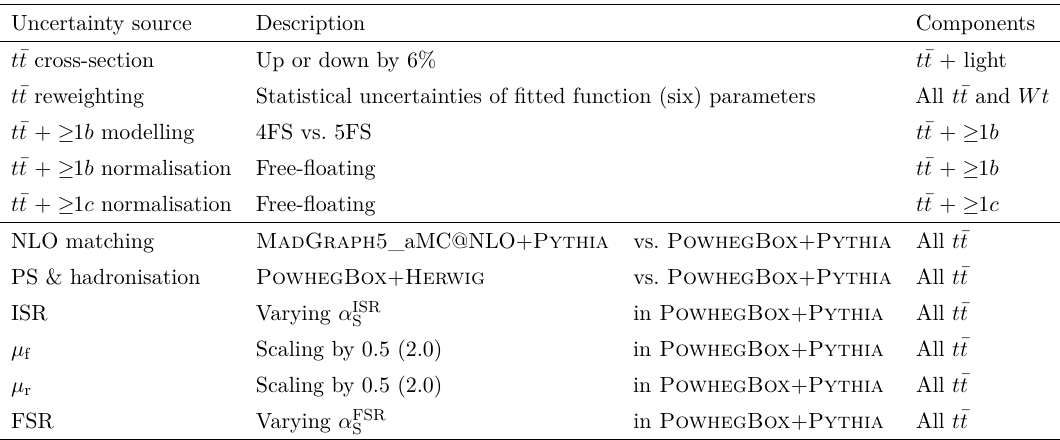
Table 2 . Summary of the sources of systematic uncertainty for t ¯ t + jets modelling. The systematic uncertainties listed in the second section of the table are evaluated in such a way as to have no impact on the normalisation of the three, t ¯ t + ≥ 1 b , t ¯ t + ≥ 1 c and t ¯ t + light, components in the phase-space selected in the analysis. The last column of the table indicates the t ¯ t + jets components to which the systematic uncertainty is assigned. All systematic uncertainty sources, except those associated to the t ¯ t reweighting, are treated as uncorrelated across the three